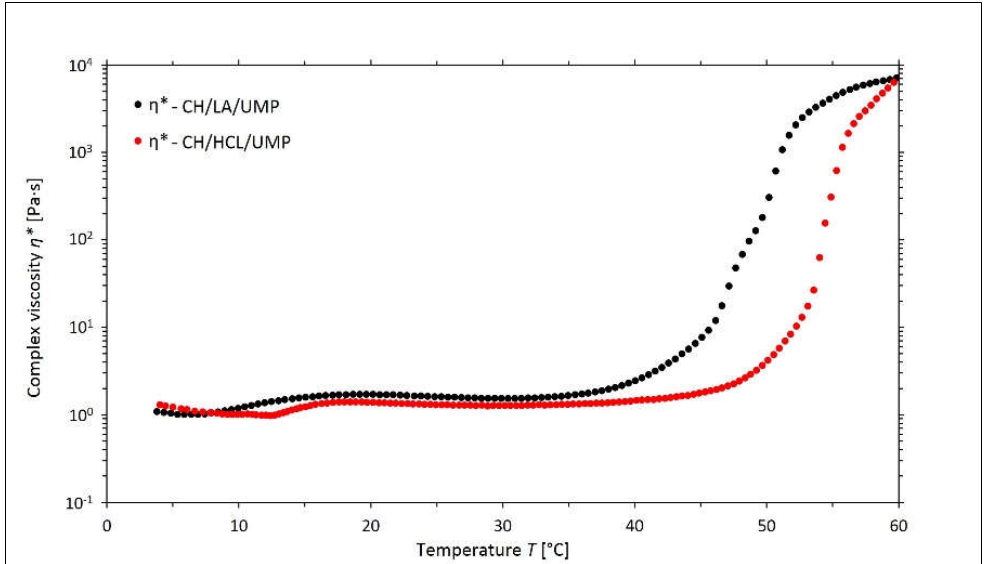
Figure 6. The experimental curves of the changes in the values of the complex viscosity η* as a function of the temperature T obtained for the chitosan lactate solutions (the CH/LA/UMP system) and chitosan chloride (the CH/HCL/UMP system) with uridine 5′-monophosphate disodium salt (UMP).